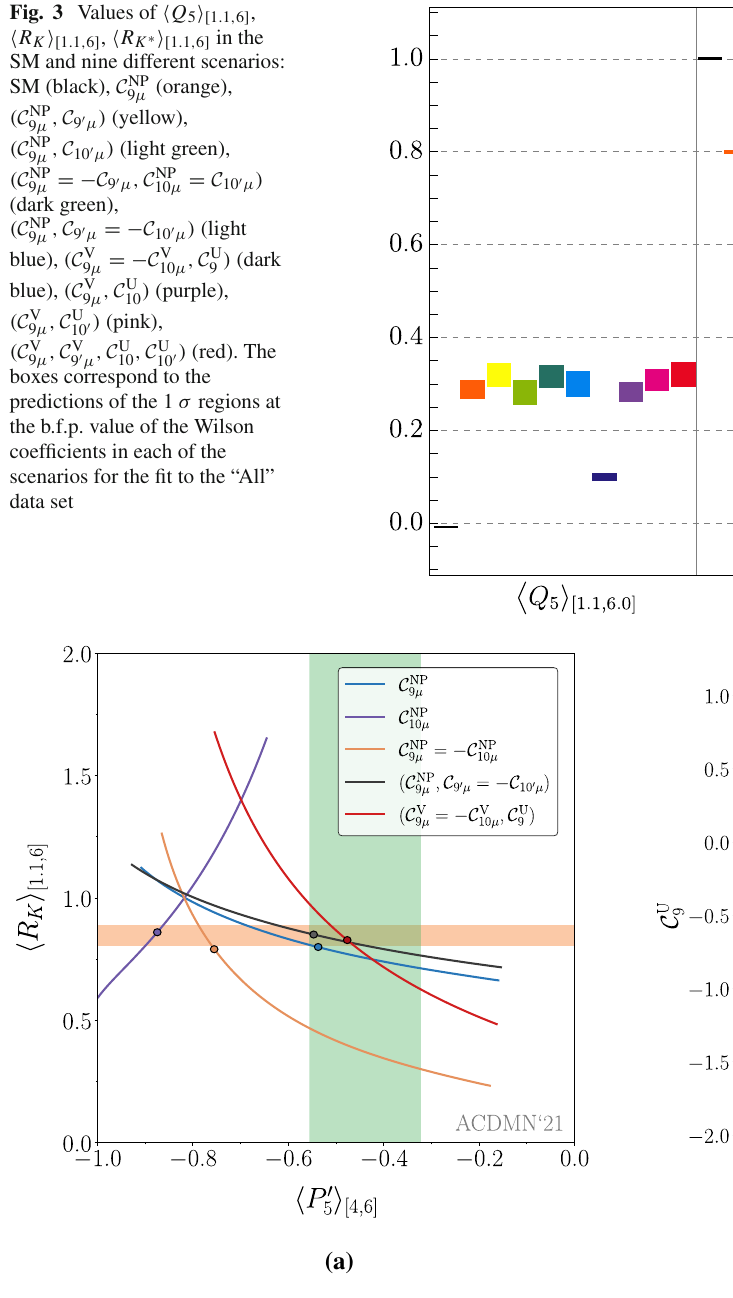
Fig. 3 Values of (cid:8) Q 5 (cid:9) [ 1 . 1 , 6 ] , (cid:8) R (cid:9) [ (cid:8) R (cid:9) [ K K ∗ 1 . 1 , 6 ] , 1 . 1 , 6 ] in the SM and nine different scenarios: